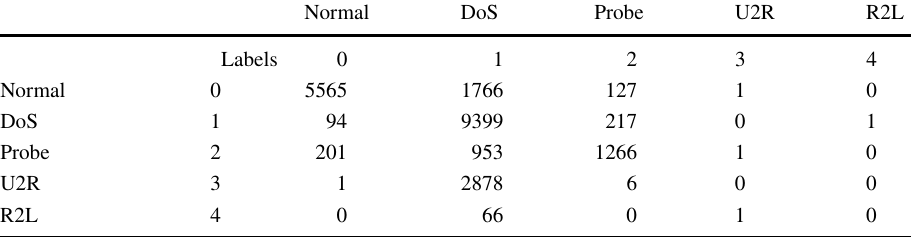
Table 9 Confusion